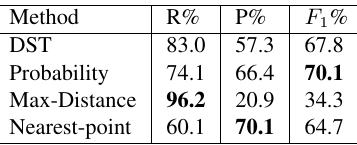
Table 1. Accuracy assessment of moving object detection at